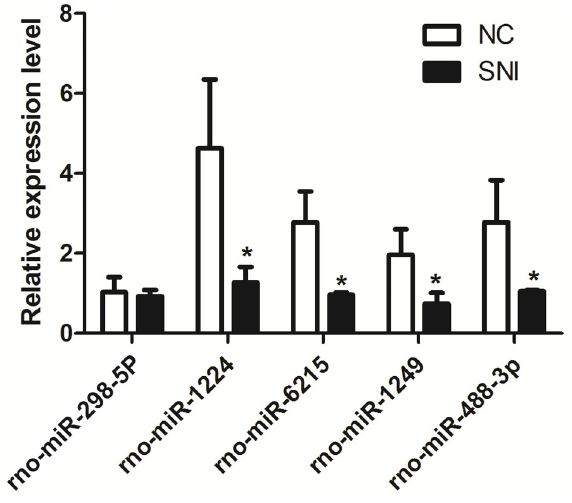
Figure 5. Real-time PCR validation of the differentially expressed miRNAs identi fi ed from small RNA sequencing. *P o 0.05 ( t -test), n=3. SNI: spared nerve injury rats; NC: sham-operated